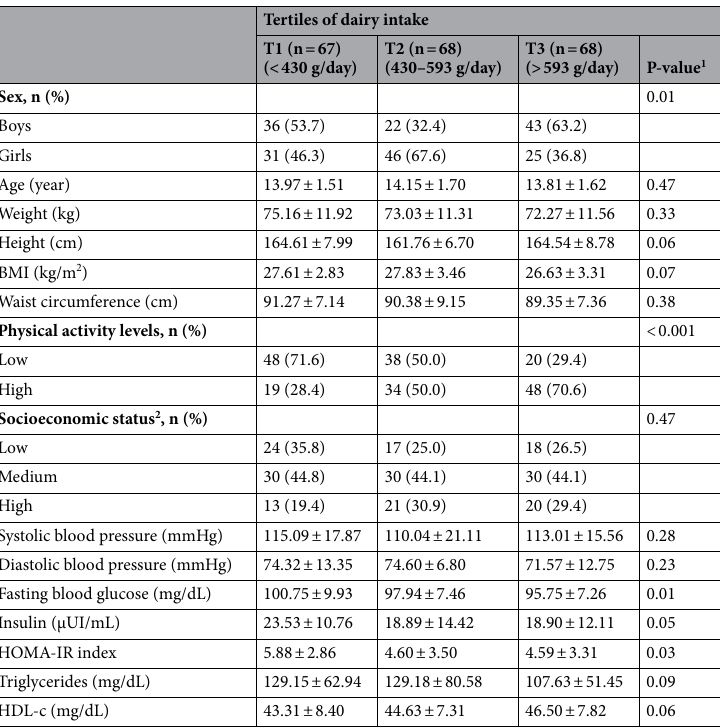
Table 1. General characteristics and cardiometabolic factors of study participants across energy-adjusted tertiles of dairy intake. Values are Mean ± SD; unless indicated. BMI Body Mass Index, HOMA Homeostasis Model Assessment Insulin Resistance, HDL-c high-density lipoprotein cholesterol. 1 Obtained from one-way ANOVA and χ 2 test for quantitative and categorical variables, respectively. 2 Socioeconomic status (SES) score was evaluated based on parental education level, parental job, family size, having car in the family, having computer/laptop, having personal room and having travel by using a validated